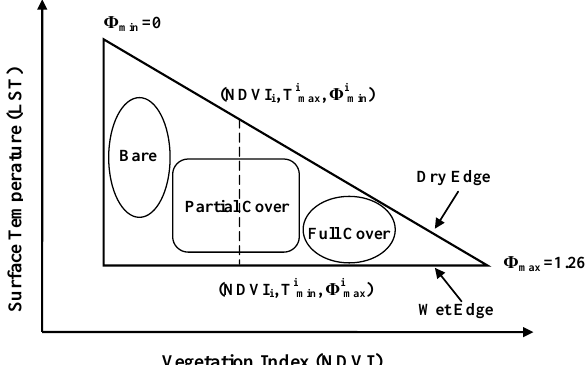
Vegetation Index (NDVI) Fig. 1. Conceptual diagram of the LST/NDVI scatter plot to estimate evaporative Fig. 1. Conceptual diagram of the LST/NDVI scatter plot to esti- fraction using wet and dry surfaces assumption. The dry (upper solid line) and wet mate evaporative fraction using wet and dry surfaces assumption. (lower solid line) edges represent the maximum ET and minimum ET, respectively The dry (upper solid line) and wet (lower solid line) edges repre- (after Tang et al., 2010; Lambin and Ehrlich (1996) and Sandholt et al. (2002)). sent the maximum ET and minimum ET, respectively (after Tang et al., 2010; Lambin and Ehrlich, 1996; and Sandholt et al.,